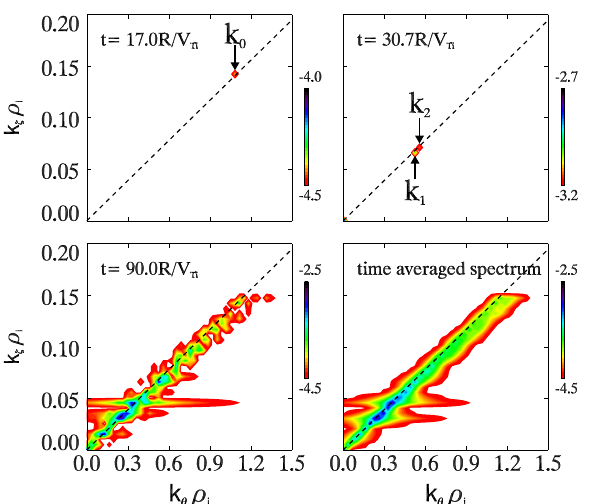
Figure 1. Simulation setup of radial profiles. Safety factor q and magnetic shear R / L Ti 2.2 and R / L Te 6.9 (middle figure), ion T i and electron T e temperature (bottom gradients R / L n = = = figure).